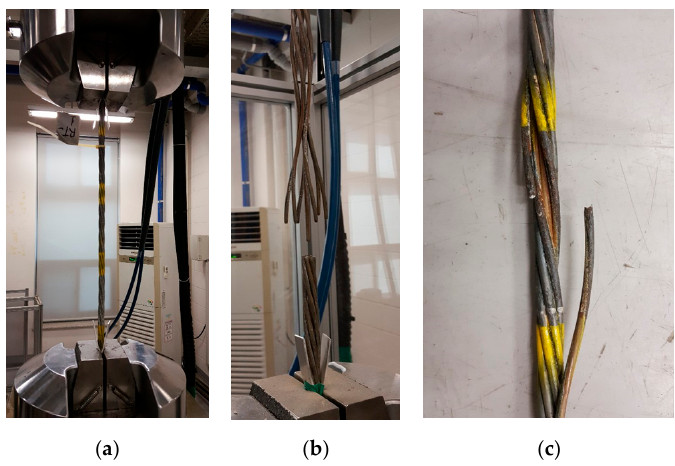
Table 1. Mechanical properties of the non-corroded strands.